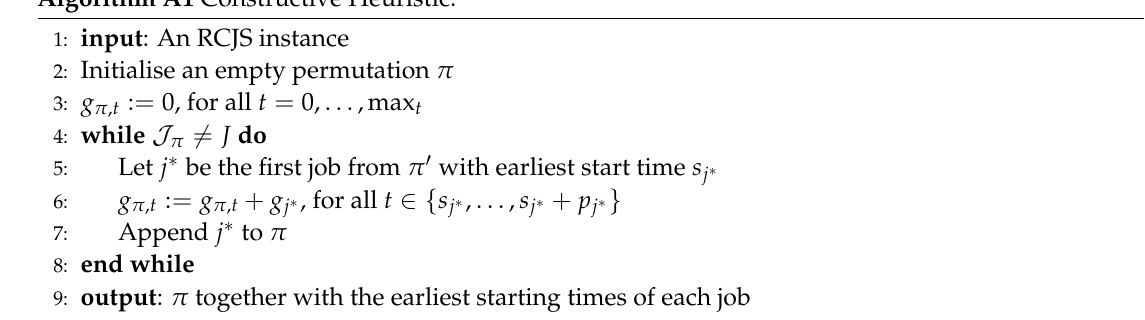
Algorithm A1 Constructive Heuristic.